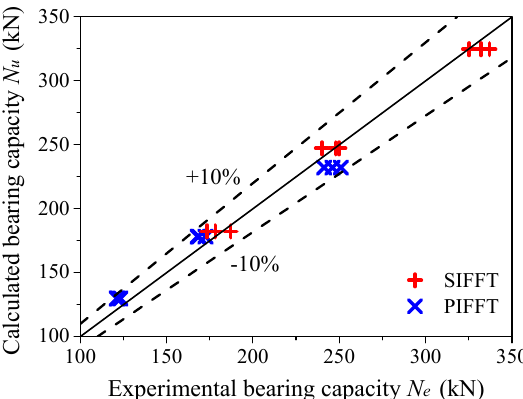
Figure 20. Comparison of ultimate bearing capacities between calculated and experimental results.